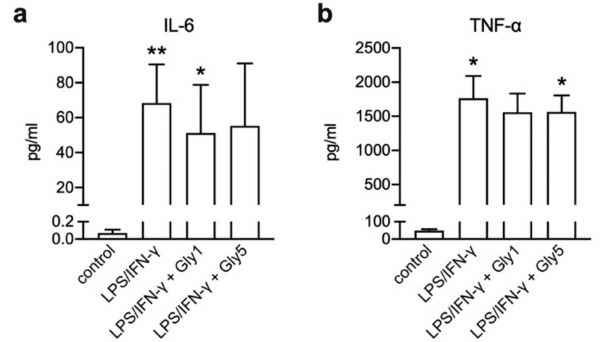
Figure 6. Release of ( a ) IL-6 and ( b ) TNF- α upon LPS / IFN- γ treatment for 24 h in the absence and presence of 1 or 5 mM glycine. Asterisks indicate significances compared to control (* p < 0.05; ** p < 0.01). Seven independent experiments were performed per